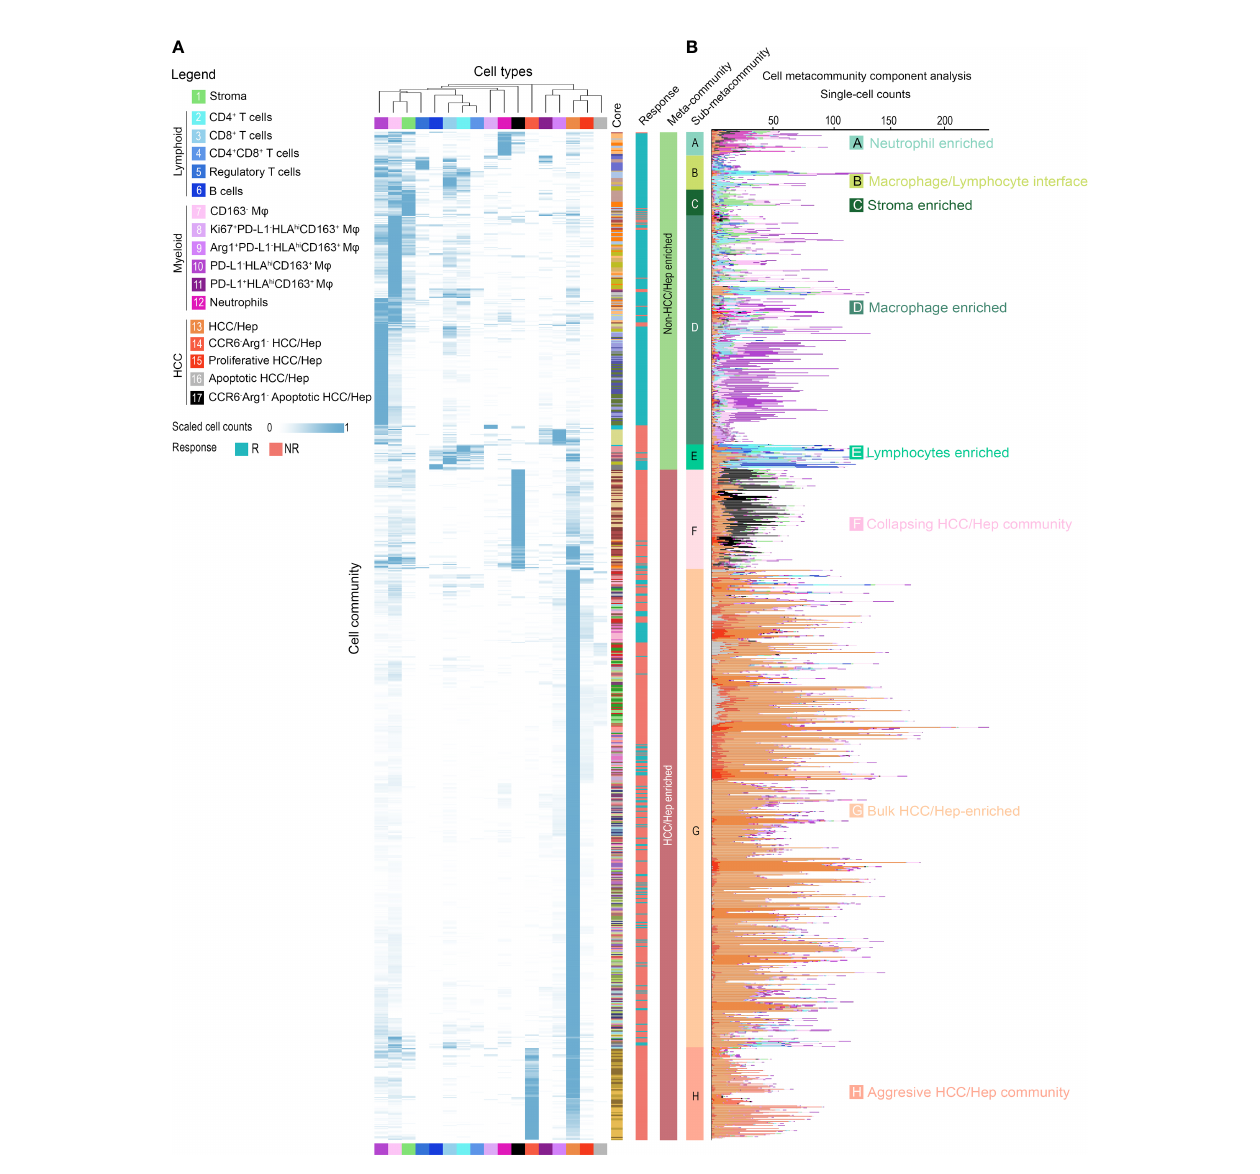
FIGURE 6 | Cellular community analysis identi fi es cell communities within HCC tumor microenvironment. Hierarchical clustered (A) heatmap and (B) stacked bar plot of scaled and absolute cell-type counts in each cell community. Colored columns indicate the originated core (n = 37), response criteria, assigned community and meta-community